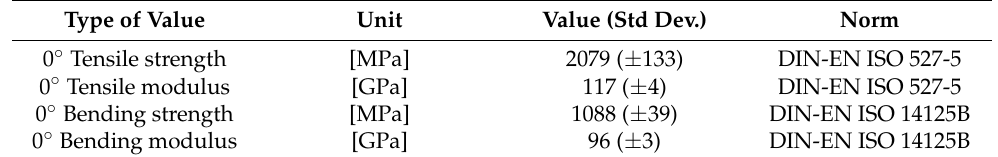
Table 5. Mechanical values of no gaps, 8 mass-% binder content-0% 90 ◦ plies; FVF normalised to 55%. Type of Value Unit Value (Std Dev.)